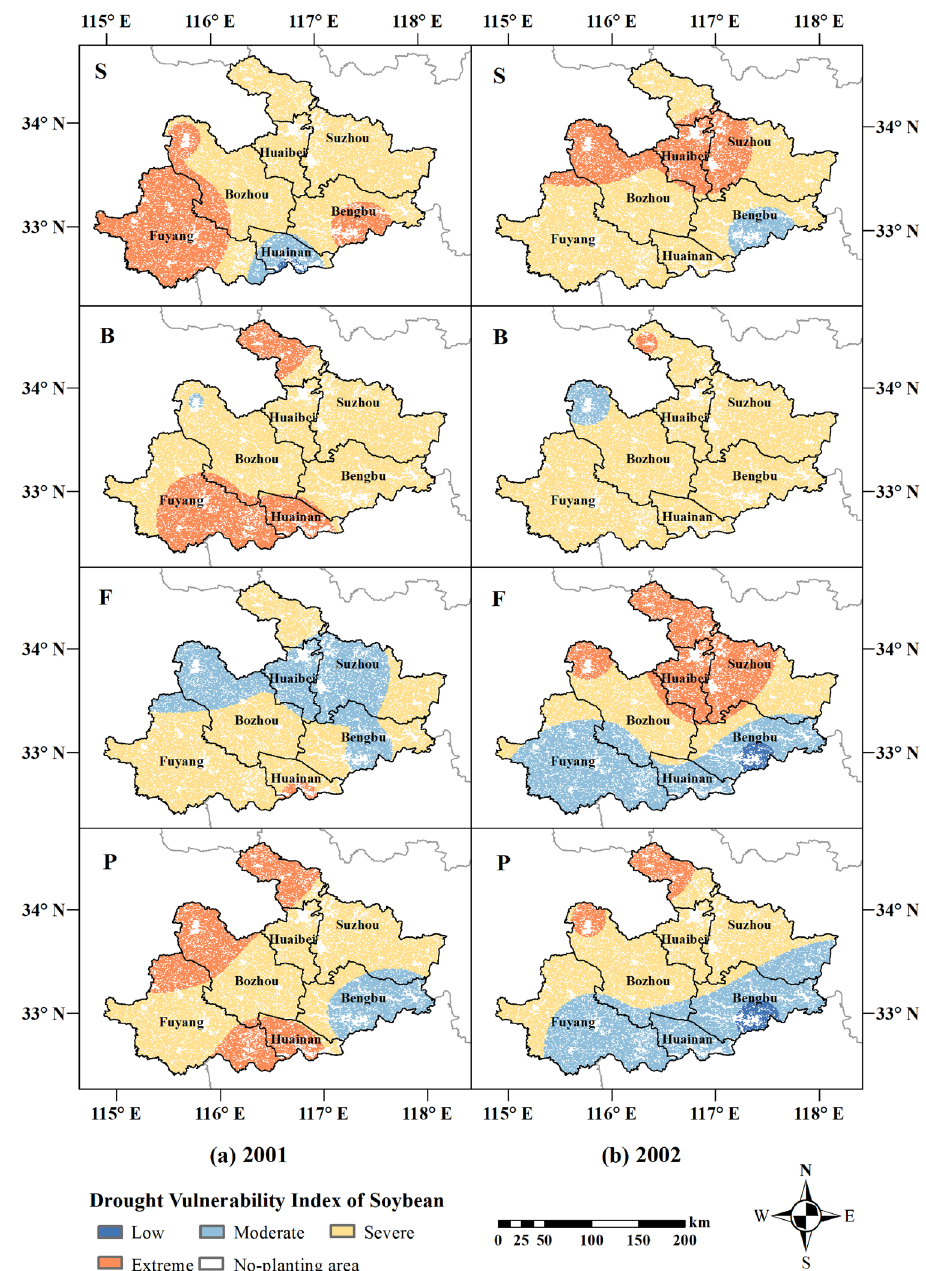
Fig. 8 Spatial distribution of the soybean growth-stage-based drought vulnerability index (GDVI) at different growth stages in 2001 and 2002 in the Huaibei Plain study area in Anhui Province,